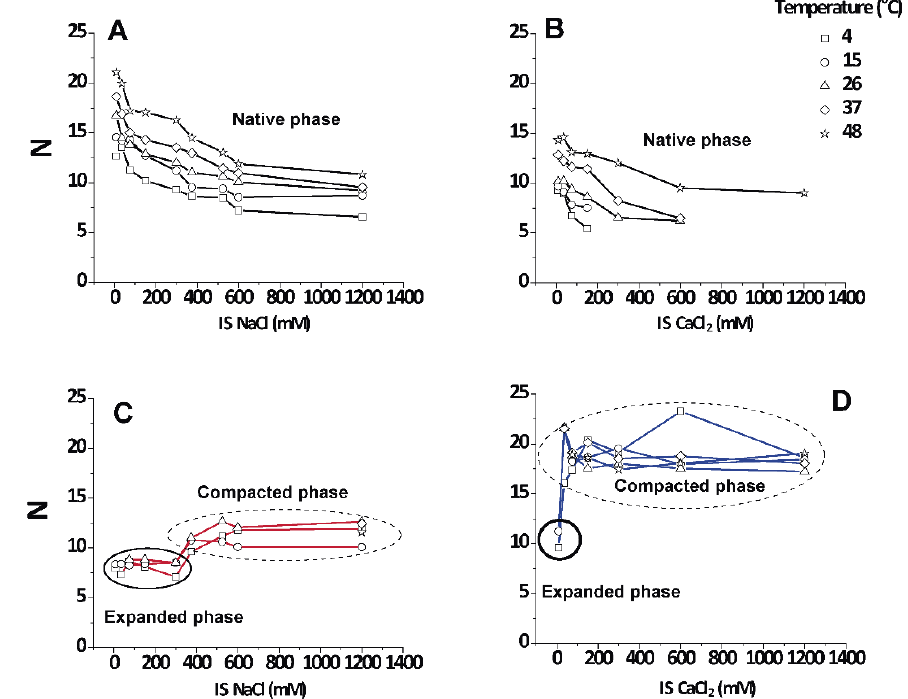
Figure 5. Number of periodically correlated bilayers ( 𝑵 ) as a function of IS and temperature for the different phases present in PMMs. The graphics show 𝑁 for the native phase in NaCl ( A ) and CaCl 2 ( B ), and for the non-native phases in NaCl ( C ) and CaCl 2 ( D ). Squares: 4 °C, circles: 15 °C, triangles: 26 °C, diamonds: 37 °C; stars: 48 °C.